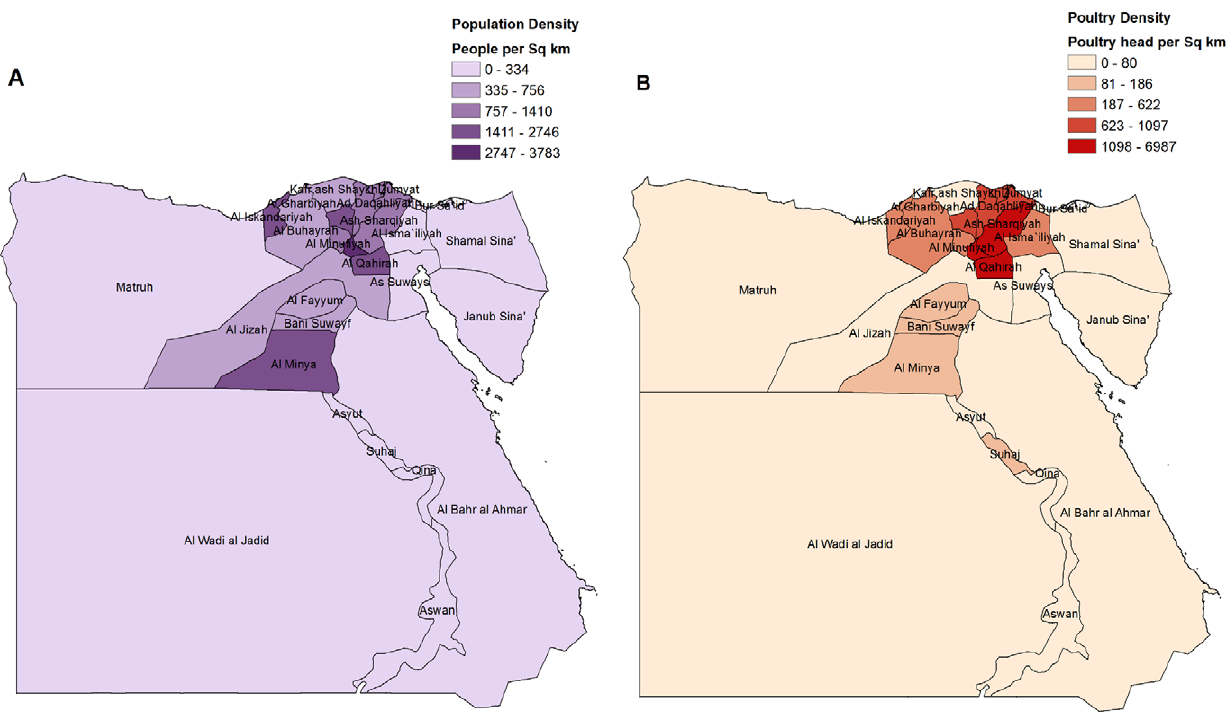
Figure 4. A. Population density map (people per square km), Egypt. B. Poultry density map (poultry head per sq km), Egypt.